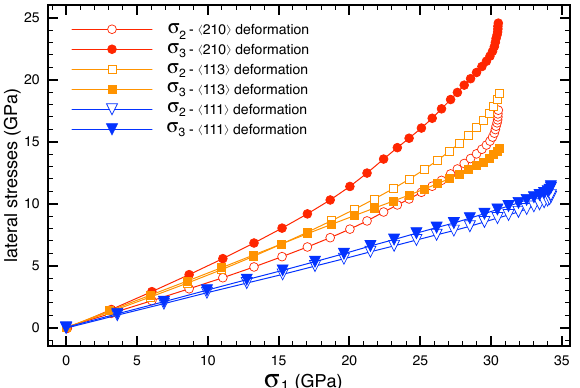
Figure 5. The relationship between the transverse stresses σ 2 , σ 3 and the axial stress σ 1 computed for the uniaxial deformation of bulk fcc Ni in the (cid:104) 111 (cid:105) , (cid:104) 210 (cid:105) , and (cid:104) 311 (cid:105) crystallographic